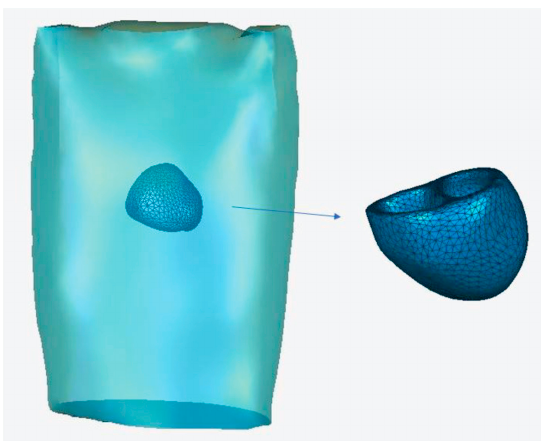
Figure 2. Finite element mesh of patient-specific heart-torso model (anterior view, half-transparency) with enlarged heart